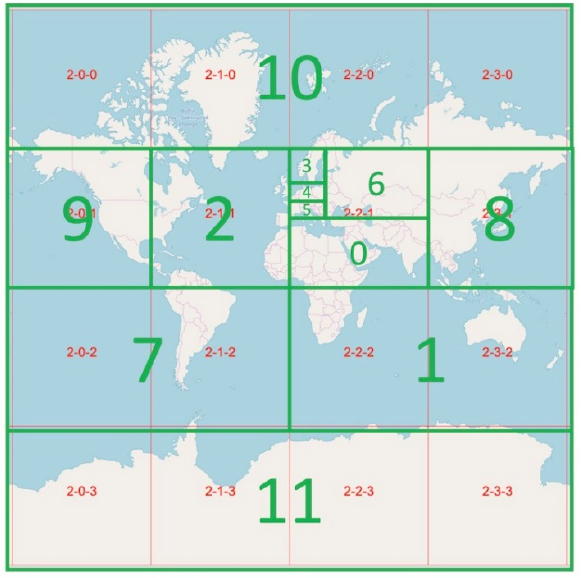
Figure 3. Division of globe into 12 areas based on the distribution of OpenStreetMap